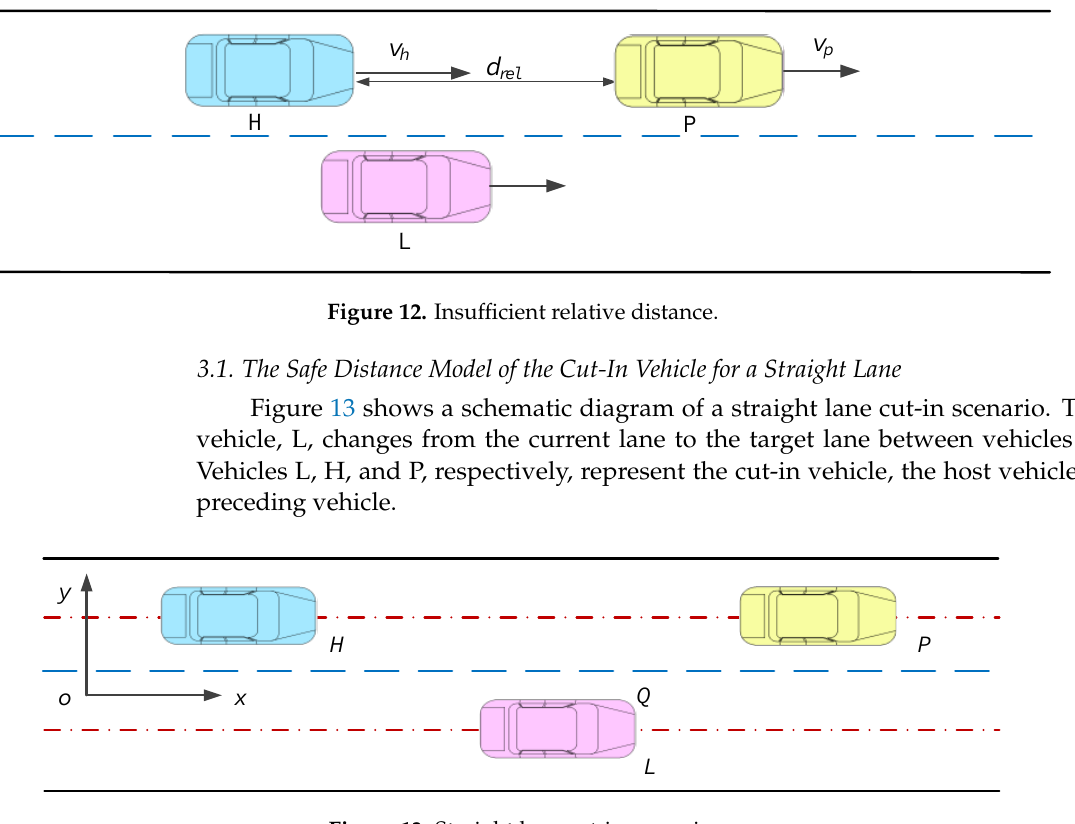
L Figure 14. The position of cut-in vehicle L and preceding vehicle P. The lateral acceleration of preceding vehicle P is 0, and the lateral position is constant. Assuming that the time at collision point c is c